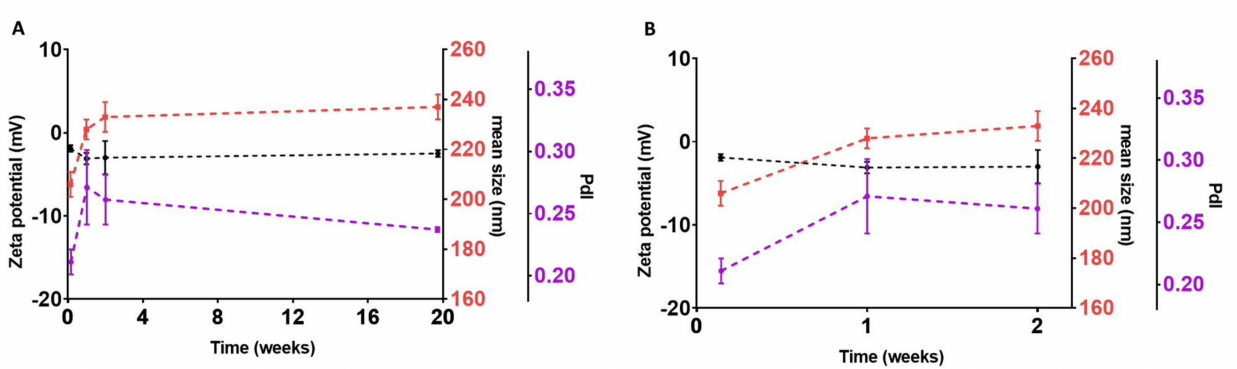
Figure 1. ( A ) Stability of the selected unloaded SLNs formulation at days 1, 7, 14 and 138. An enlargement of the first 14 days is presented in ( B ). Black line: Graphical representation of variations in ZP values (data plotted on the left Y-axis); Red line: Graphical representation of variations in mean sizes (data plotted on the first right Y-axis); Purple line: Graphical representation of variations in PdI values (data plotted on the second right Y-axis). Results are given as mean ± SD ( n =